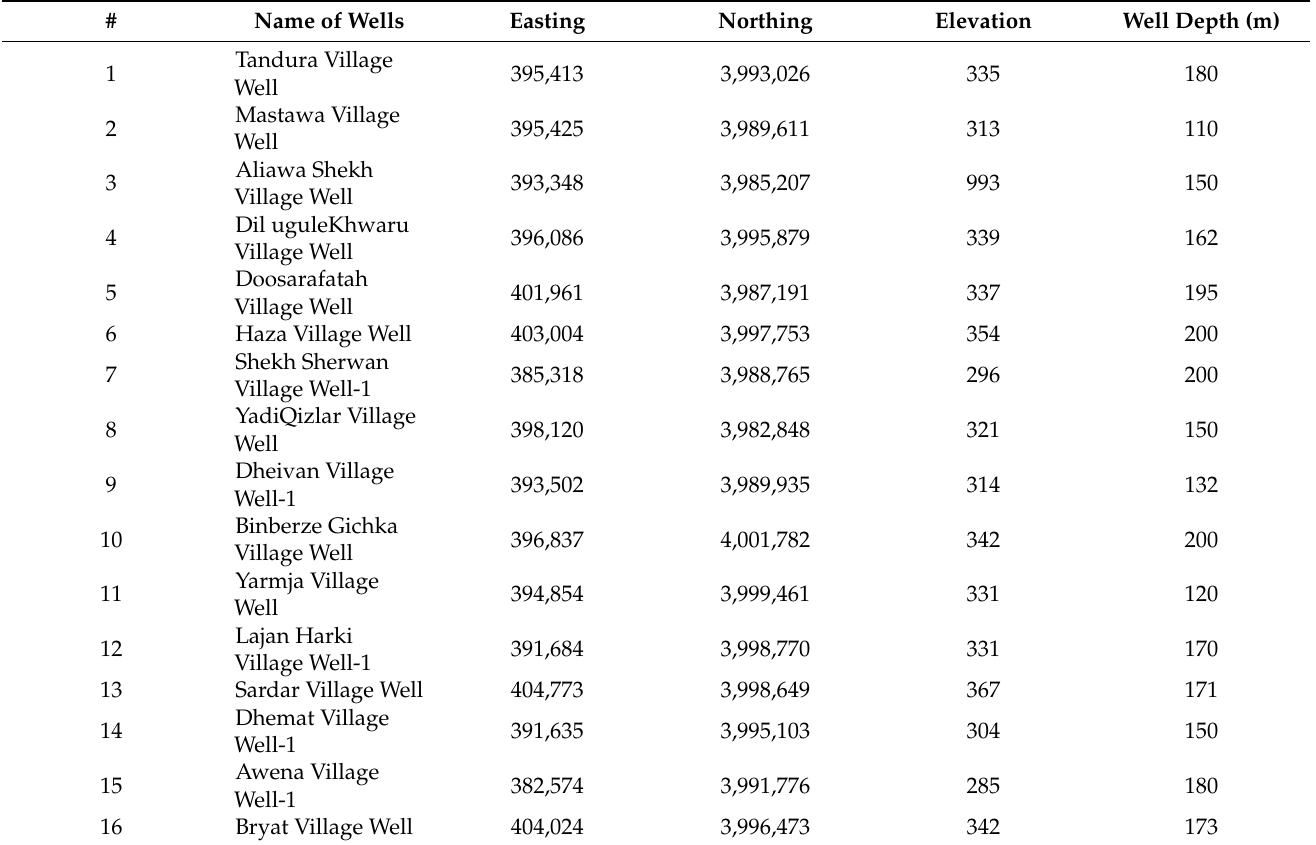
Table 1. Locations and depths of the wells in the Erbil plain area, UTM Coordination